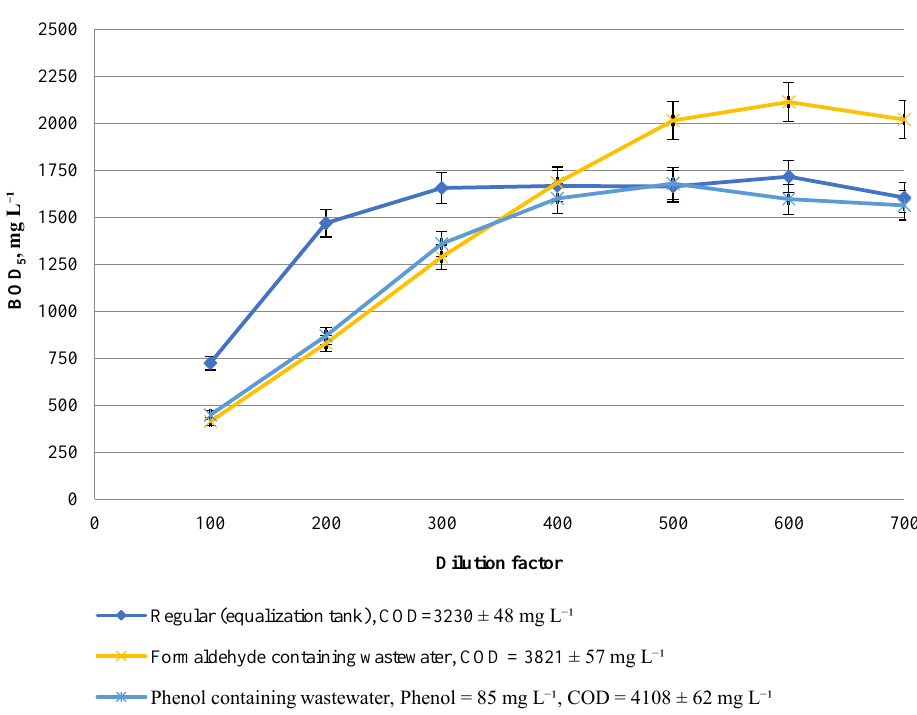
Fig. 1. BOD 5 values of pharmaceutical wastewater's streams containing harmful organic compounds depending on dilution factor. Results show that the biodegradation curves of wastewater containing phenol and formaldehyde reach the plato phase only at dilution factor of 500. Construction of an equalization tank appears to be of extreme importance in order to ensure dilution of toxic wastewater streams and avoid toxic shock to biological treatment system treating pharmaceutical wastewater. The obtained data can be used to estimate amount of specific wastewater that will not affect the stability of the biological treatment process and can be discharged into WWTP. However, it should be considered, that possible synergistic or antagonistic interactions between pollutants are possible